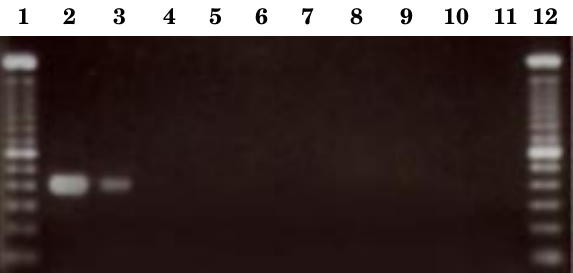
Fig. 2. Amplification products of direct polymerase chain reaction using the primer-pair Dest1 and Dest4 for dif- ferent fungal cultures. Lanes: 1 and 12, molecular weight markers (100 bp; GIBCO-BRL, Life Technologies); 2, positive control (Cy1); 3–10, Cylindrocarpon obtusispo- rum, Botrytis cinerea, Fusarium oxysporum, Fusicoccum sp., Phaeomoniella chlamydospora, Pestalotiopsis mene- zesiana, Phomopsis sp . and Truncatella angustata ; 11, negative